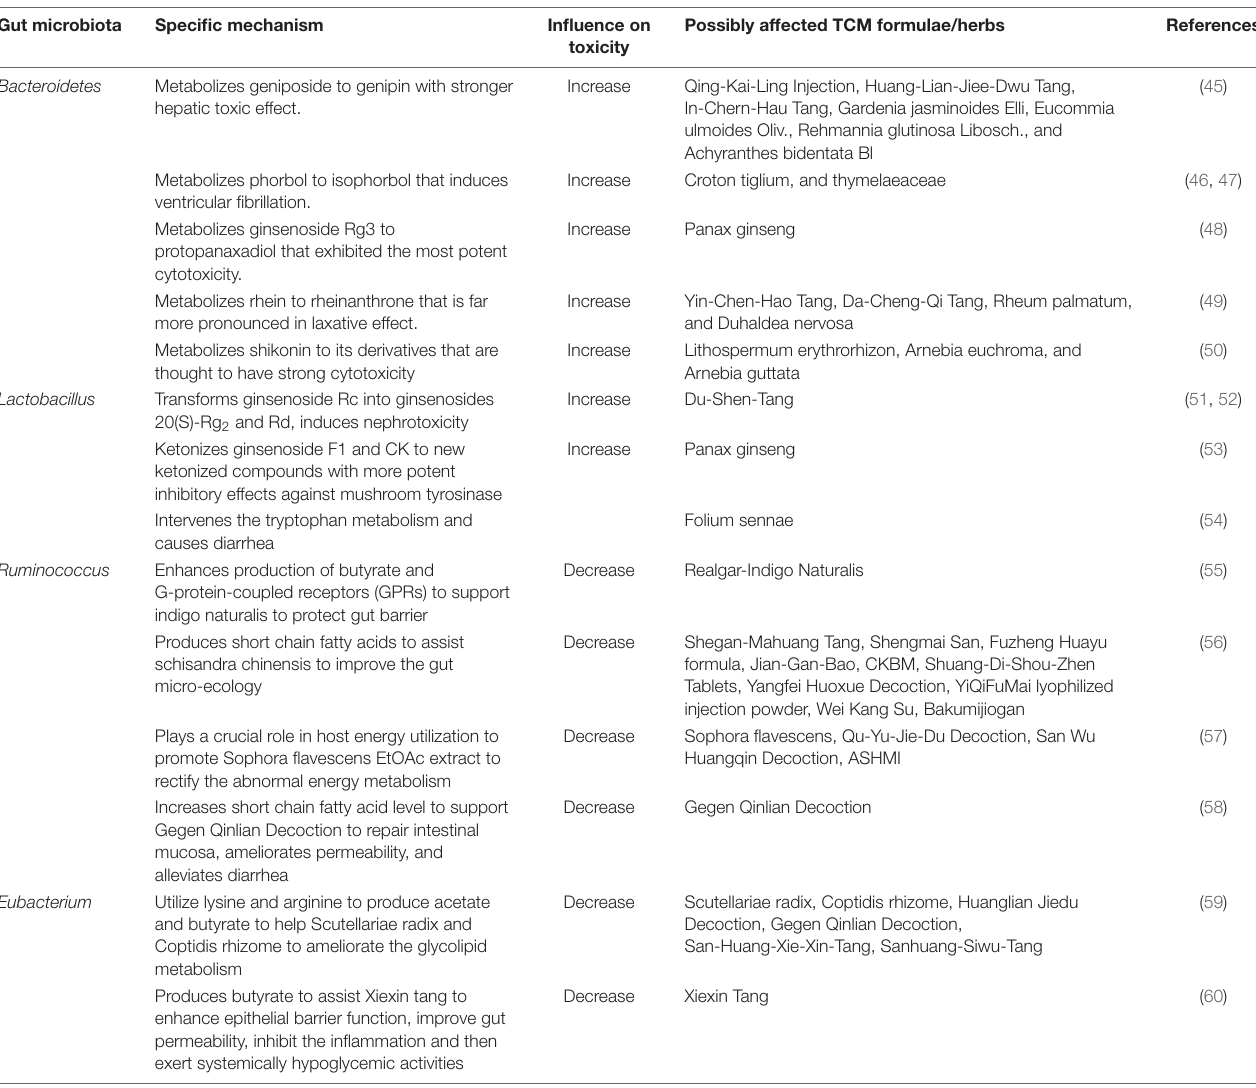
TABLE 4 | Roles of gut microbiota on toxicity of